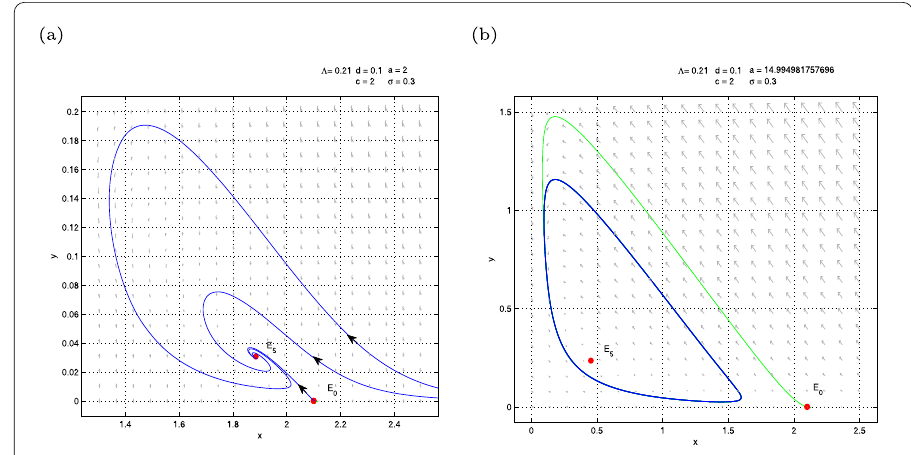
Figure 3 When R 0 > 1. ( a ) ψ 5 < 0, the disease-free equilibrium E 0 is unstable and the unique positive equilibrium E 5 is globally stable. ( b ) ψ 5 > 0, E 0 and E 5 are unstable and there exists a stable limit cycle